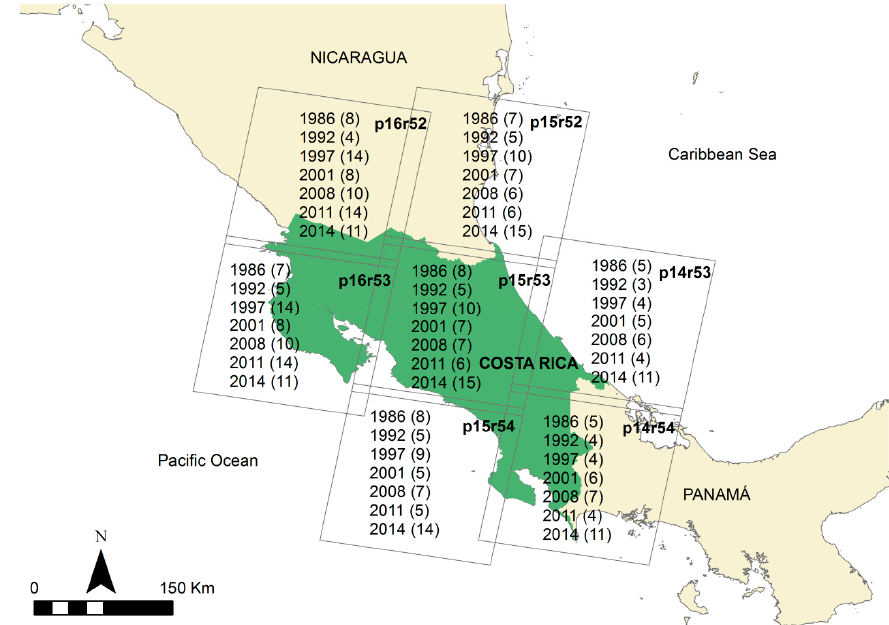
Figure 1. Details of the number of Landsat images processed for each year of the time series and each of the 7 Landsat tiles which covers Costa Rica: paths (p) 14–16, rows (r) 52–54.